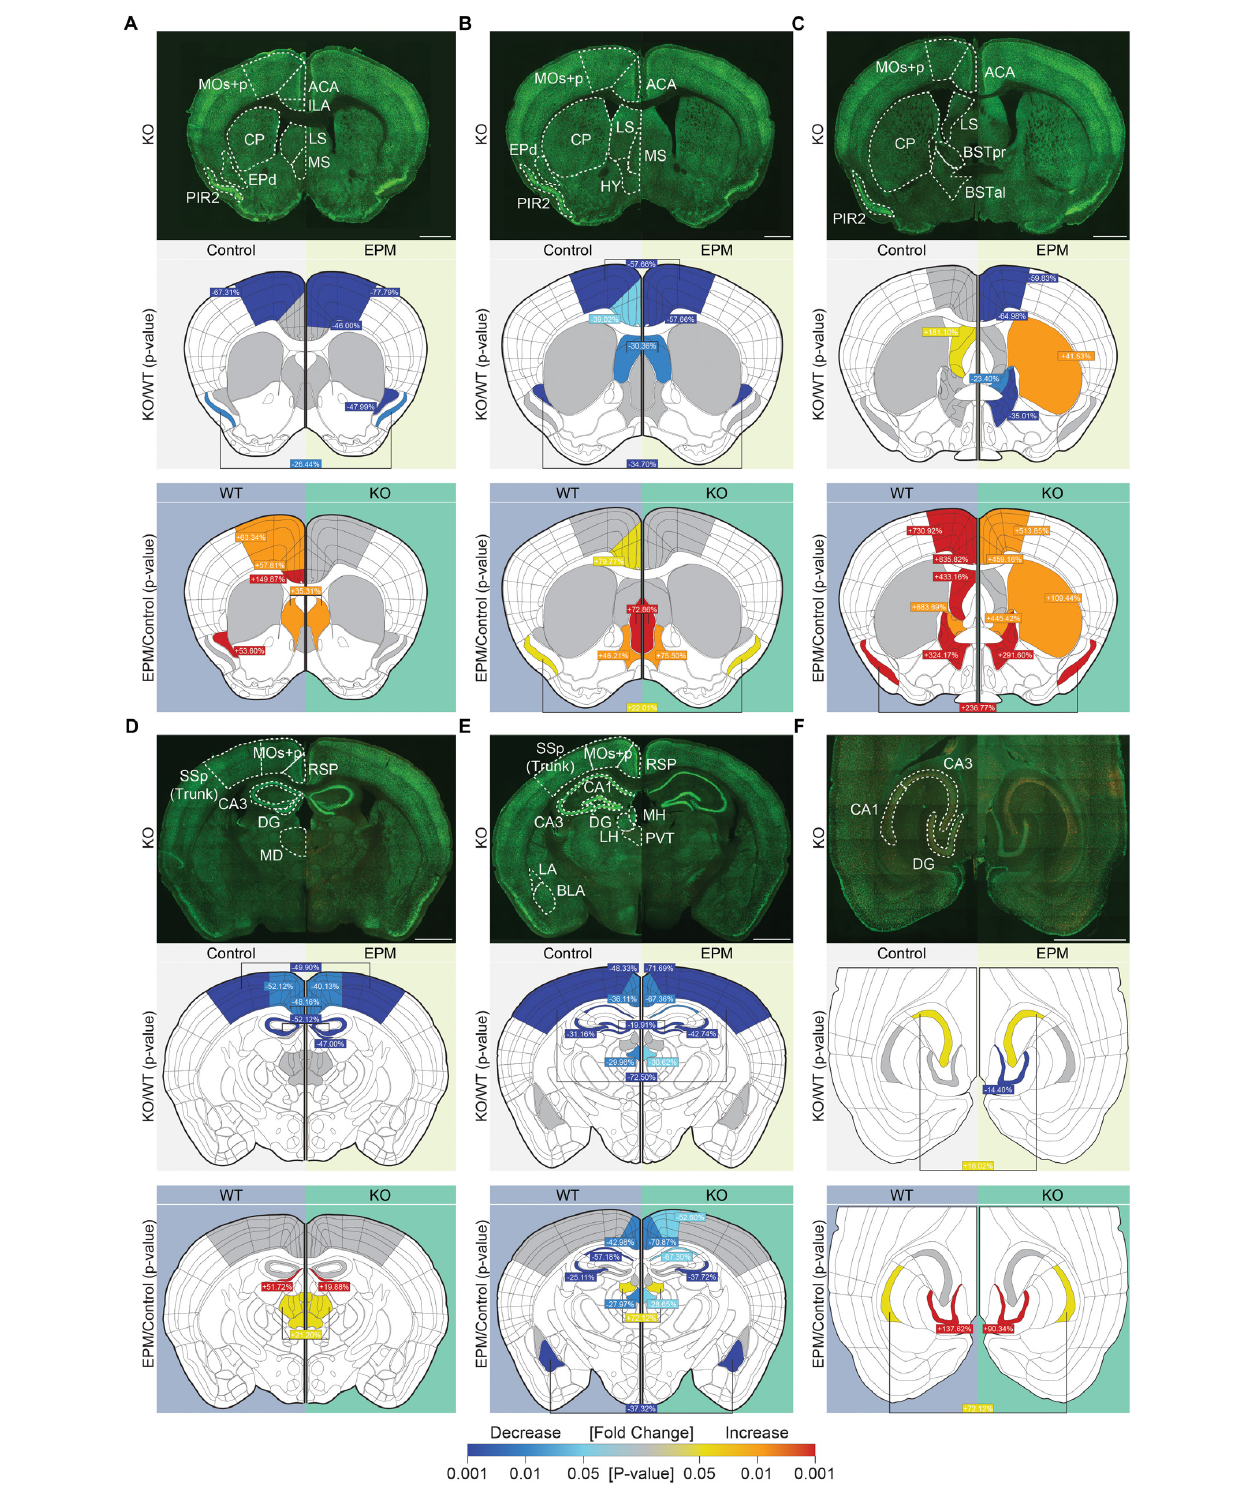
FIGURE 6 | Suppressed neuronal activity under baseline and anxiety-inducing EPM conditions in Lrrc4c − / − mice. (A–F) Representative coronal and horizontal brain sections from Lrrc4c − / − mice (3–4 months, male; row 1 of each figure panel) at six positions: (A–E) coronal sections along the rostral-caudal axis; (F) horizontal sections showing the ventral hippocampus. Brain slices were stained for c-fos (red) and the neuronal marker NeuN (green) under baseline (control; left)